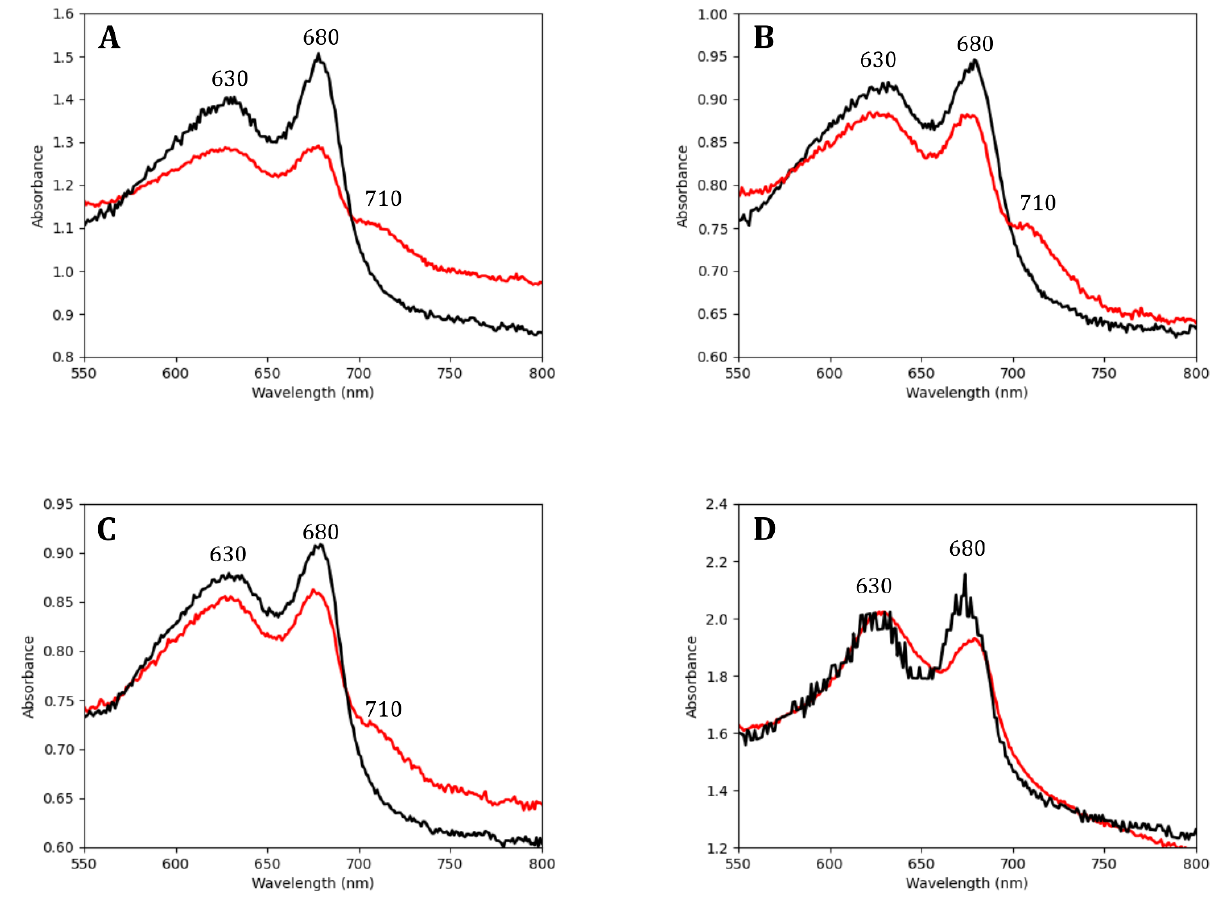
Figure 2. Comparison of absorbance spectra from whole-cell cultures grown under visible light (black line) and far-red light (red line) for Chroococcidiopsis sp. isolates from ( A ) calcite (C-VL-3P3), ( B ) gypsum (G-MTQ-3P2), ( C ) sandstone (S-NGV-2P2), and ( D ) M. aeruginosa from Lake Tai. Absorption peaks for PBP (at 630 nm), Chl a (at 680 nm), and Chl f (at 710 nm) are labeled. Cultures were grown under VL or FRL for 30 days before the experiment. Peaks were normalized to OD 575 . Each spectrum was the average of three measurements.